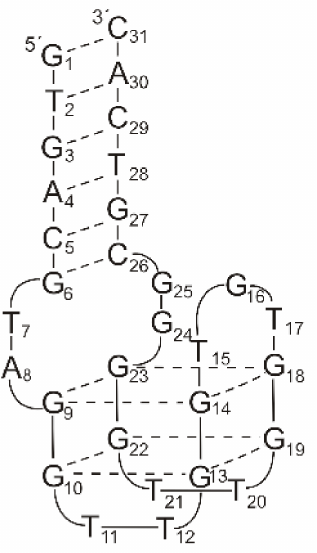
Figure 5. The structure of the RE31 quadruplex–duplex